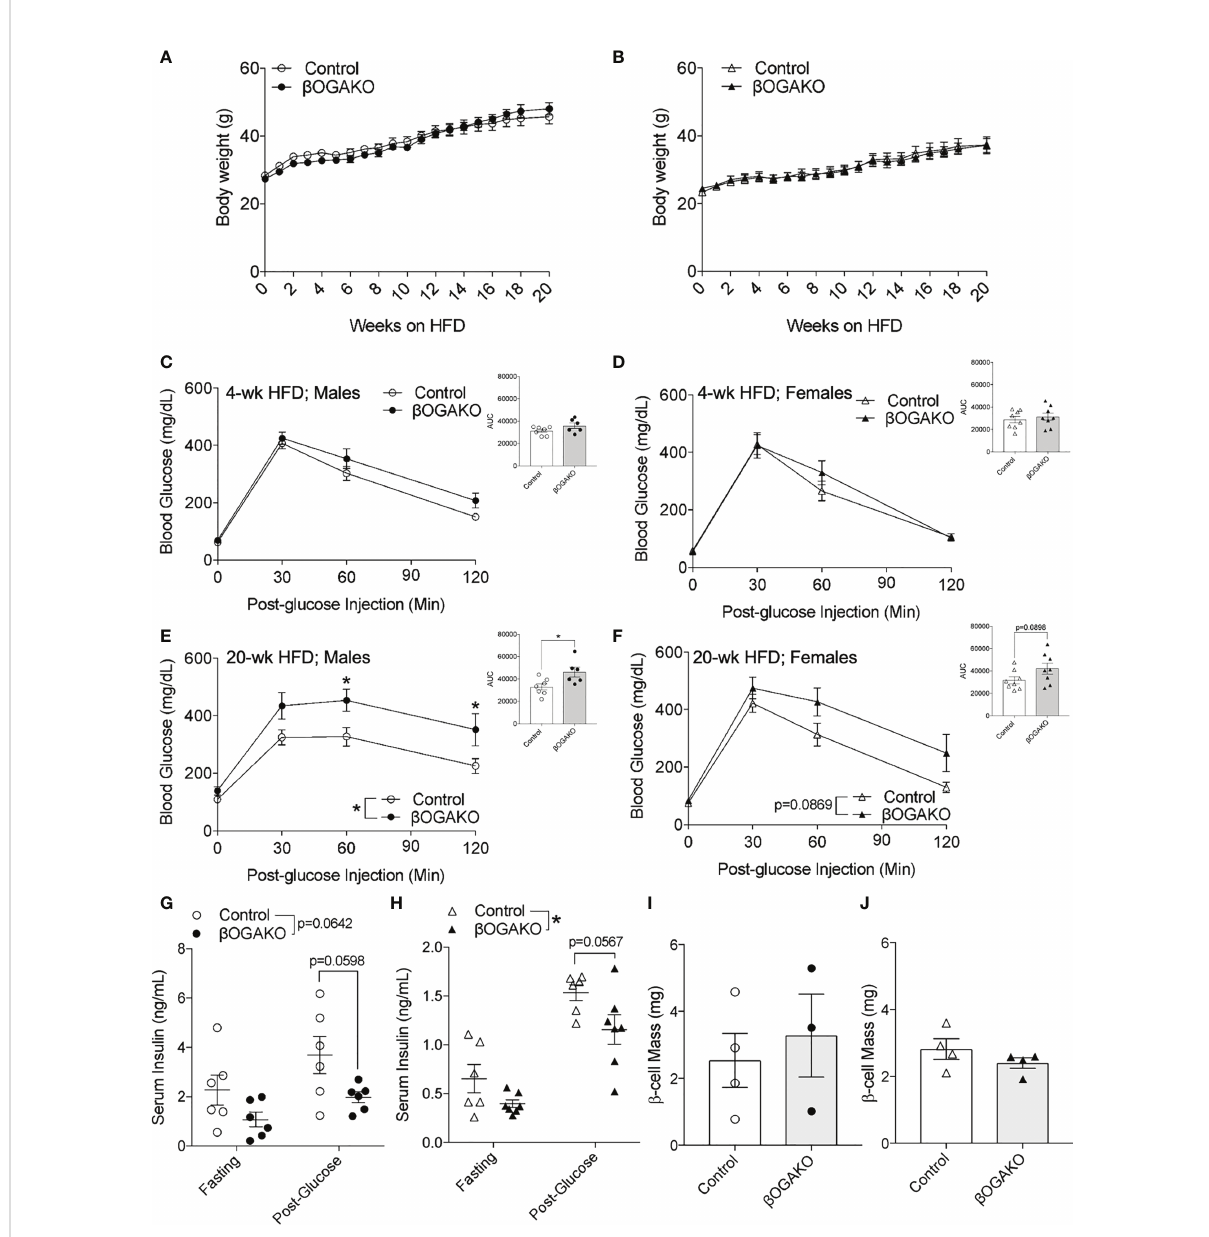
FIGURE 4 Perturbed glucose homeostasis in b OGAKO mice under high fat diet feeding. Body weight over 20-wks of high-fat-diet (HFD) feeding between control and b OGAKO male ( A , n=6-7) and female ( B , n=8) mice. In vivo glucose tolerance (2 g/kg glucose, i.p.) test on 4-wks ( C ; Male, D ; Female) and 20-wks ( E ; Male, F ; Female) post-HFD (n=6-7 for males and n=8 for females). In vivo glucose stimulated insulin secretion of male ( G , n=6) and female mice 30-wk post-HFD ( H , n=6-7). b -cell mass, assessed at 32-wk post-HFD in male ( I , n=3-4) and female mice ( J , n=4). Statistical analyses were conducted using two-way ANOVA and unpaired, 2-way student t-test with signi fi cance *p <